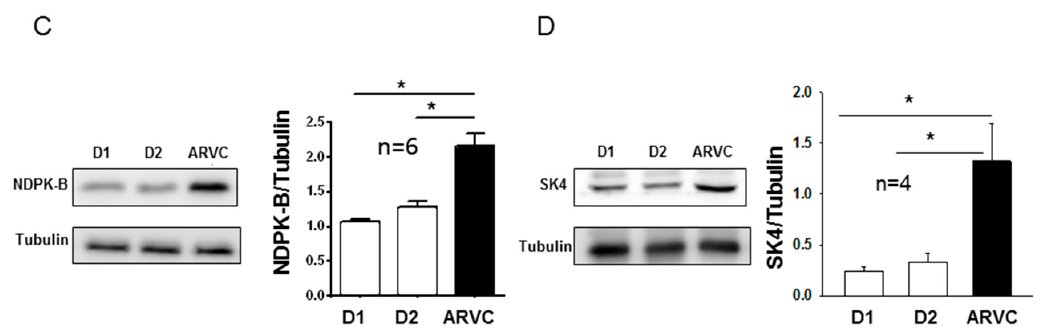
Figure 1. Expressions of nucleoside diphosphate kinase B (NDPK-B) and SK4 channel were increased in arrhythmogenic right ventricular cardiomyopathic (ARVC)-human-induced pluripotent stem cell-derived cardiomyocytes (hiPSC-CMs). Quantitative polymerase chain reaction and Western blot analyses were performed in hiPSC-CMs derived from healthy donors (D1, D2) and the ARVC-patient. ( A , B ) Relative mRNA levels of the gene expression (normalized to the housekeeping gene GAPDH) of NDPK-B ( A ) and SK4 channel ( B ). ( C ) Representative examples (left panel) and statistical data (right panel) of Western blots of cell lysates from both donor cell lines (D1, D2) and the ARVC cell line, showing the protein expression levels of NDPK-B. The intensity of the immunoreactive bands of NDPK-B protein (20 kD) was normalized to that of tubulin. ( D ) Representative examples (left panel) and statistical data (right panel) of Western blots of cell lysates from both donor cell lines (D1, D2) and the ARVC cell line, showing the expression levels of the SK4 protein (45 kD). * p < 0.05; n represents number of experiments.